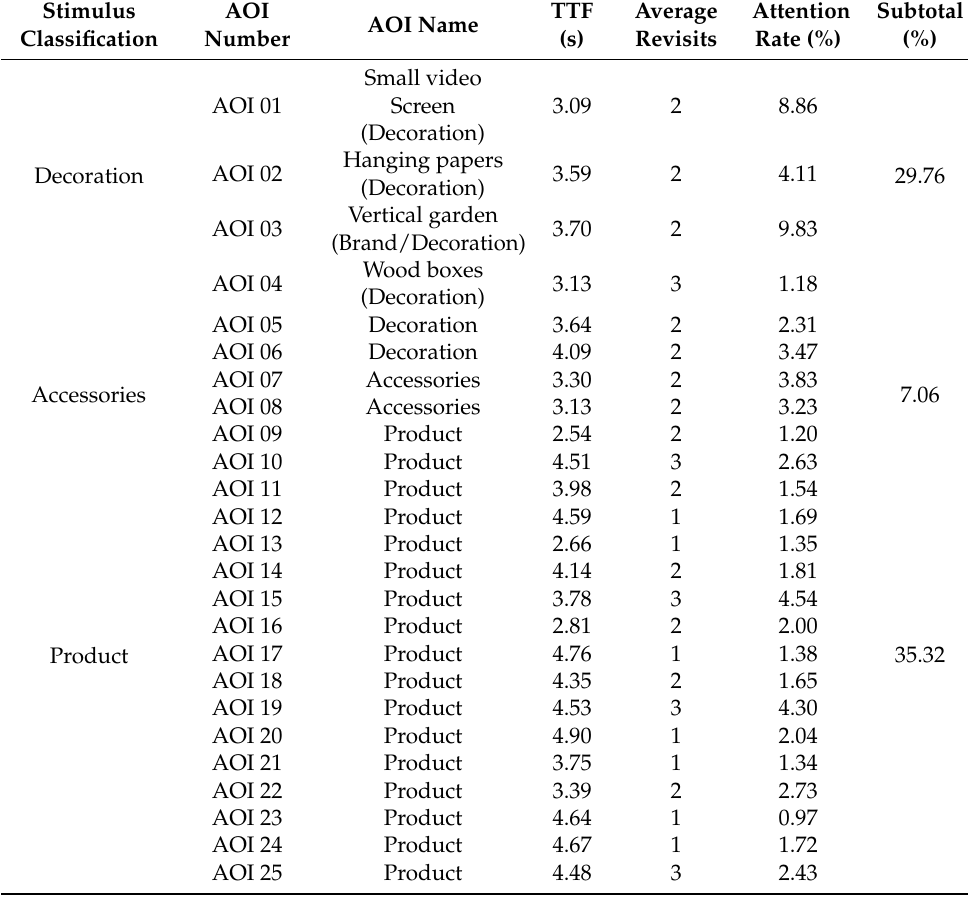
Table 5. Footwear store area. Time to First Fixation (TTF) and Attention percentage of the total number of participants to each AOI. Source: Prepared by the authors.